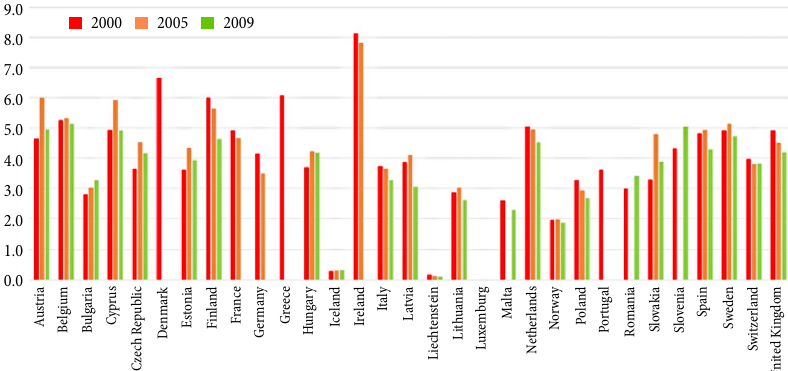
Fig. 2. Time series of CO 2 emission per PCU by countries (please note that only 2000, 2005 and 2009 were visualized in order to keep the resolution of